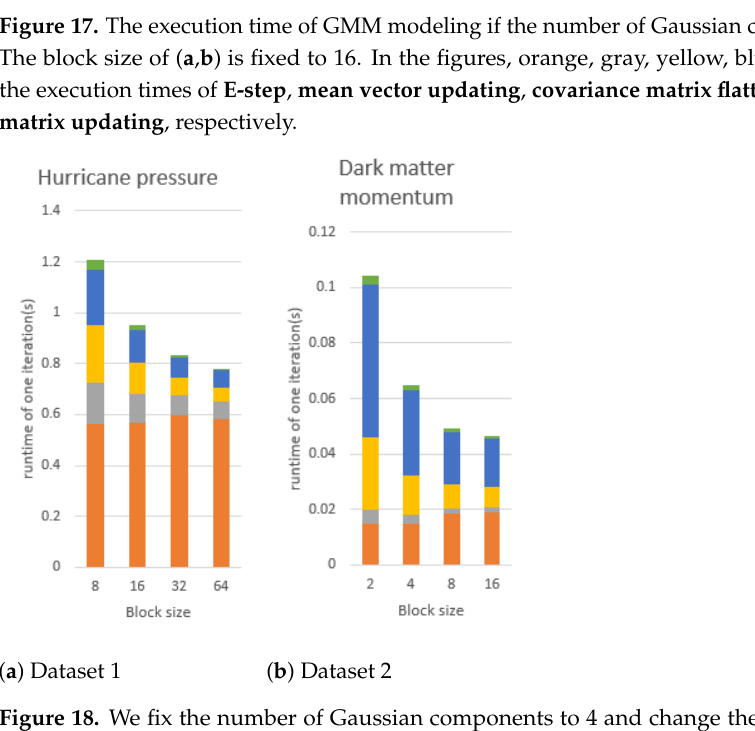
Figure 18. We fix the number of Gaussian components to 4 and change the block size to conduct this experiment, using dataset1 and dataset2 on the CPU using 16 core. In the figures, orange, gray, yellow, blue, and green bars are the execution time of E-step , mean vector updating , covariance matrix flattening , and covariance matrix updating , respectively. Dataset 3 is an ensemble data so there is no block size to